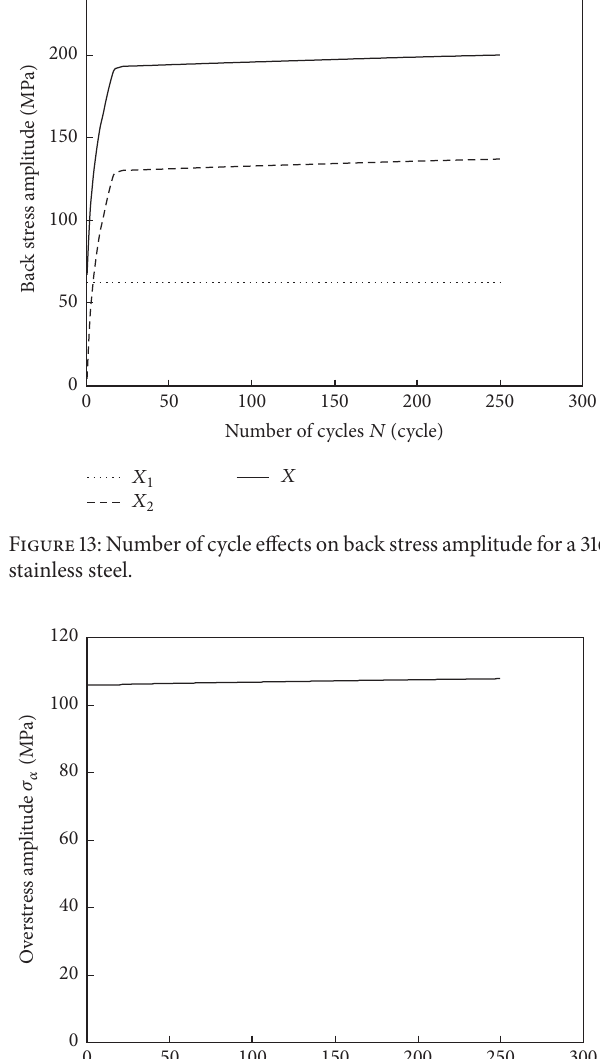
Figure 12: Number of cycle effects on total stress amplitude for a 316 stainless steel.